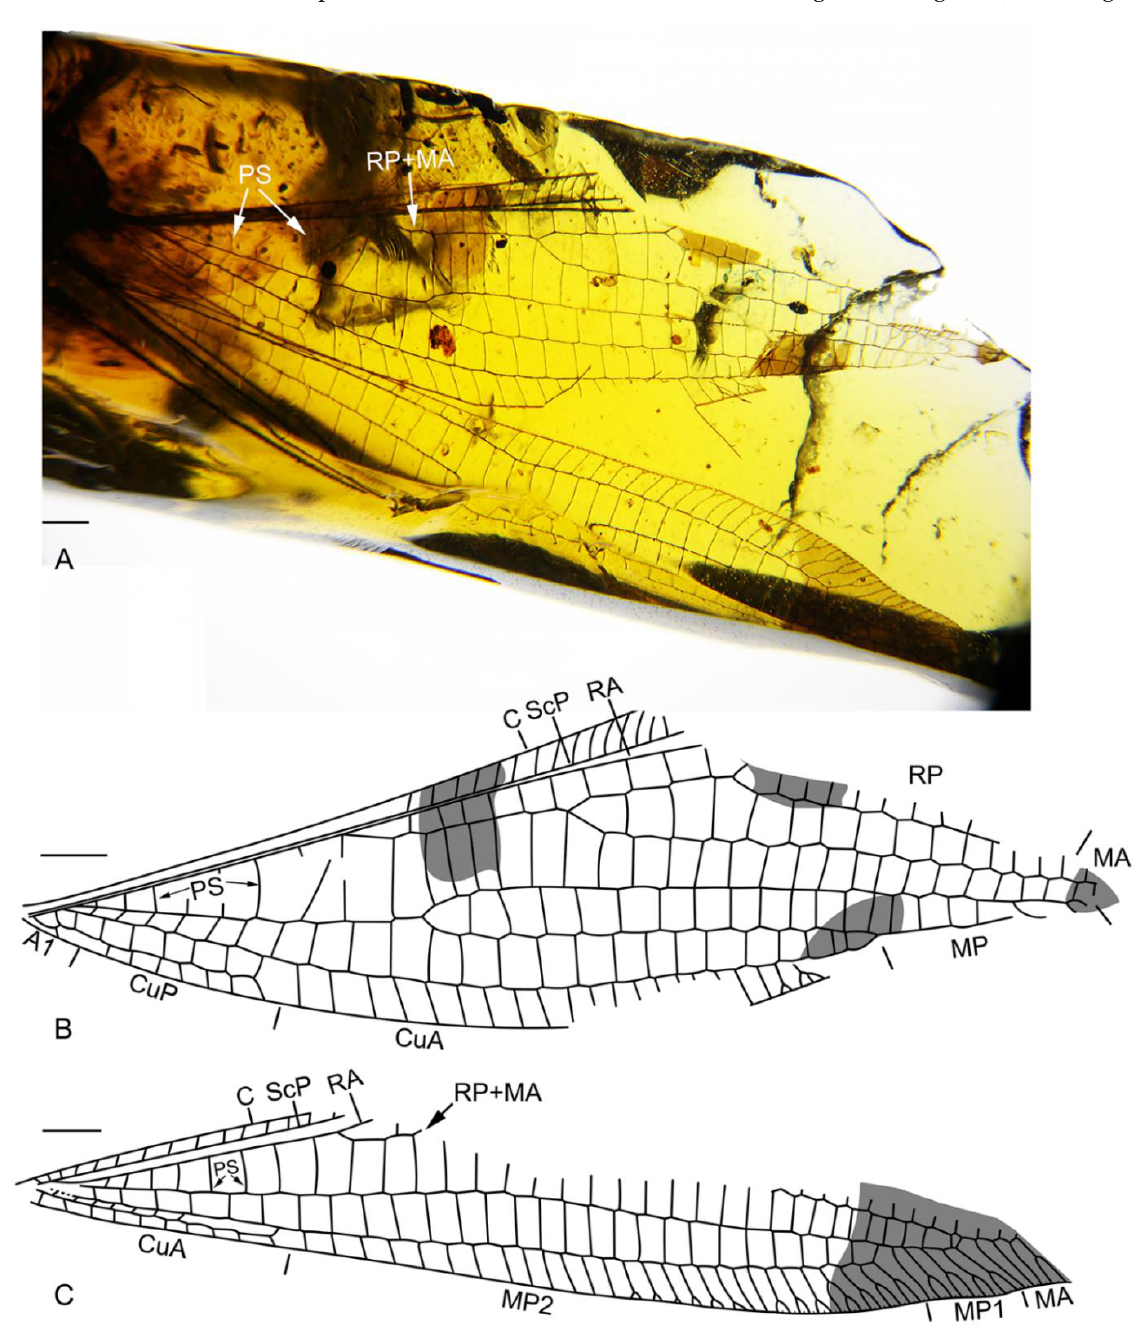
Figure 1. Araripenymphes burmanus sp. nov., holotype: NIGP180156. ( A ) Photographs of fore- and hind wings; ( B ) drawing of forewing; ( C ) drawing of hind wing. Scale bar = 1.0